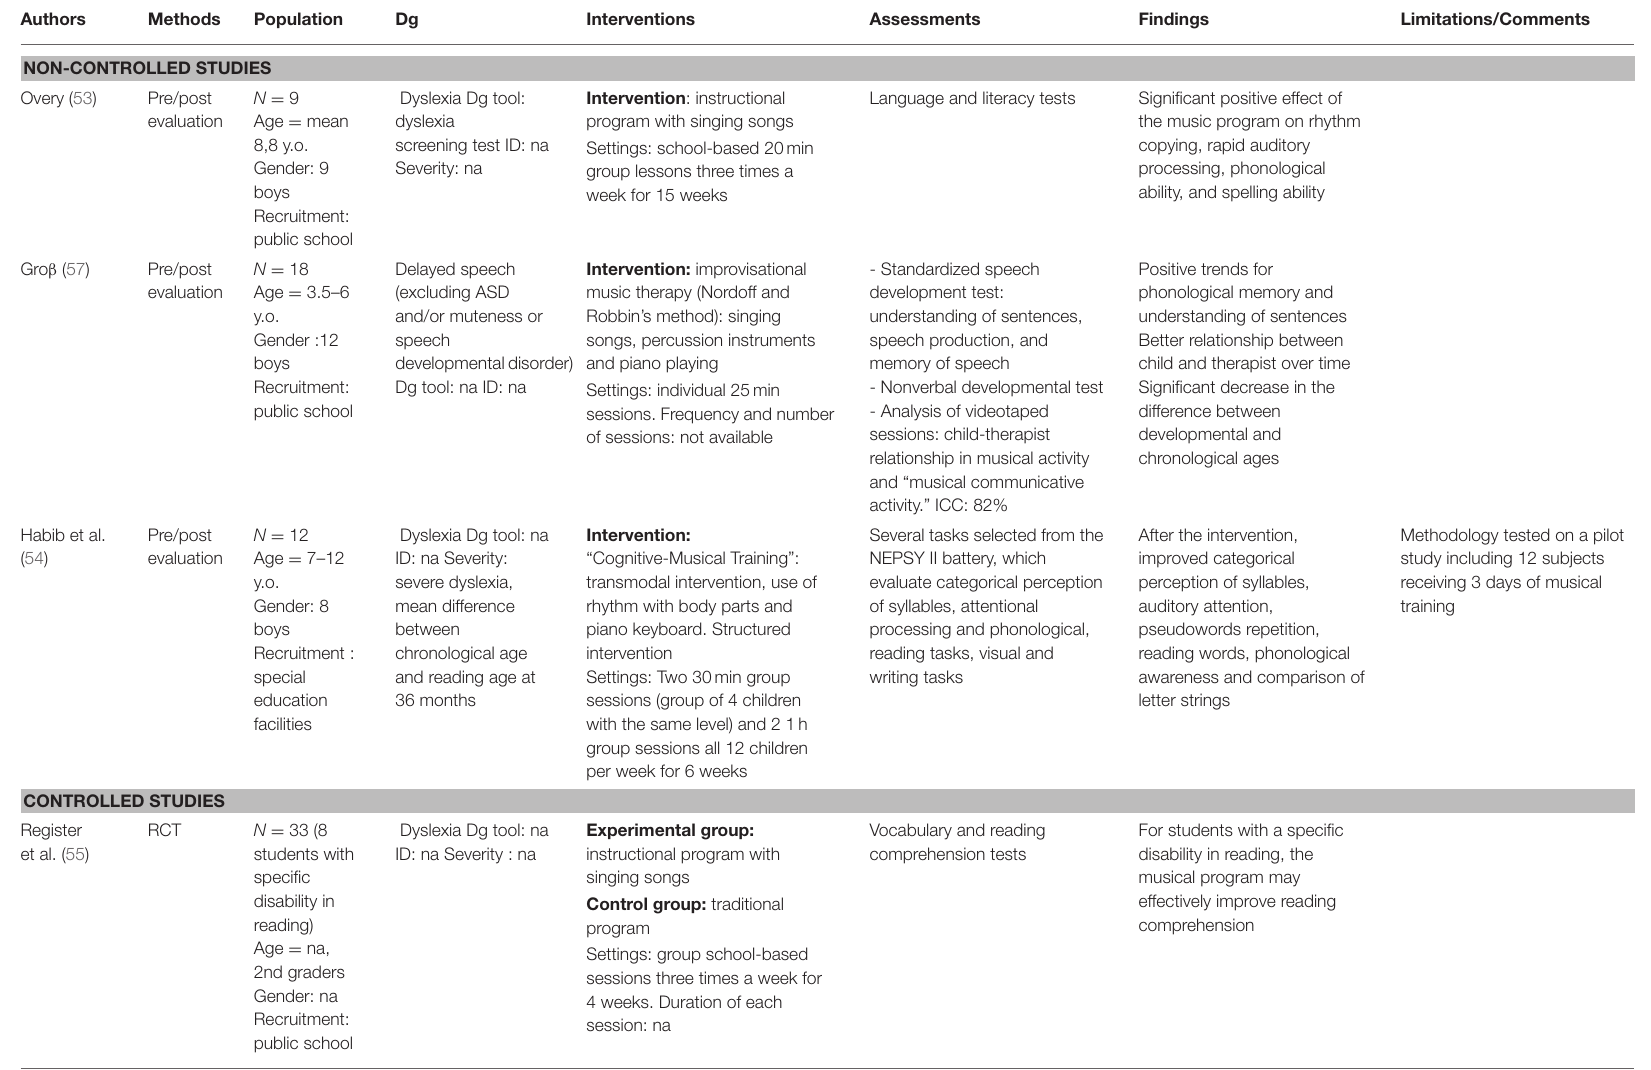
TABLE 5 | Studies assessing musicotherapy in children with communication/oral and written language